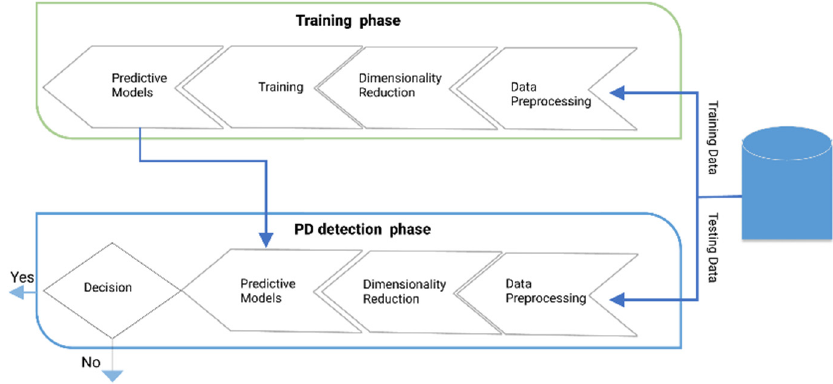
Figure 1. Flow chart of PD detection.